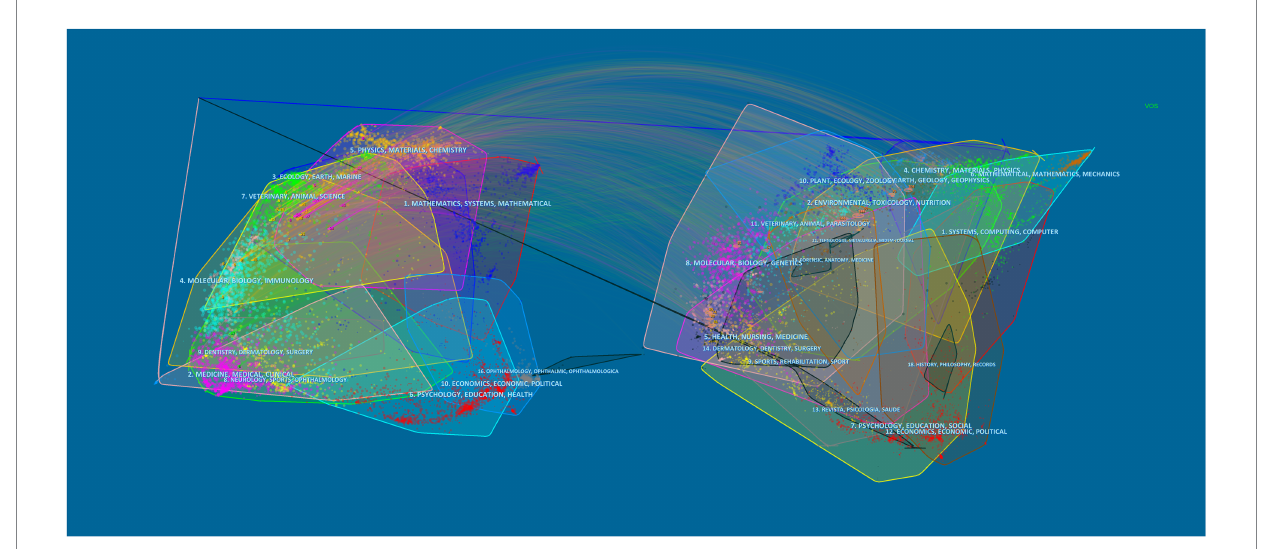
FIGURE 3 The dual-map overlay of journals on biomaterials eradicating Helicobacter pylori . The double map overlay of journals shows the relationship between the two and the distribution among journals, with the citing journals on the left and the cited journals on the